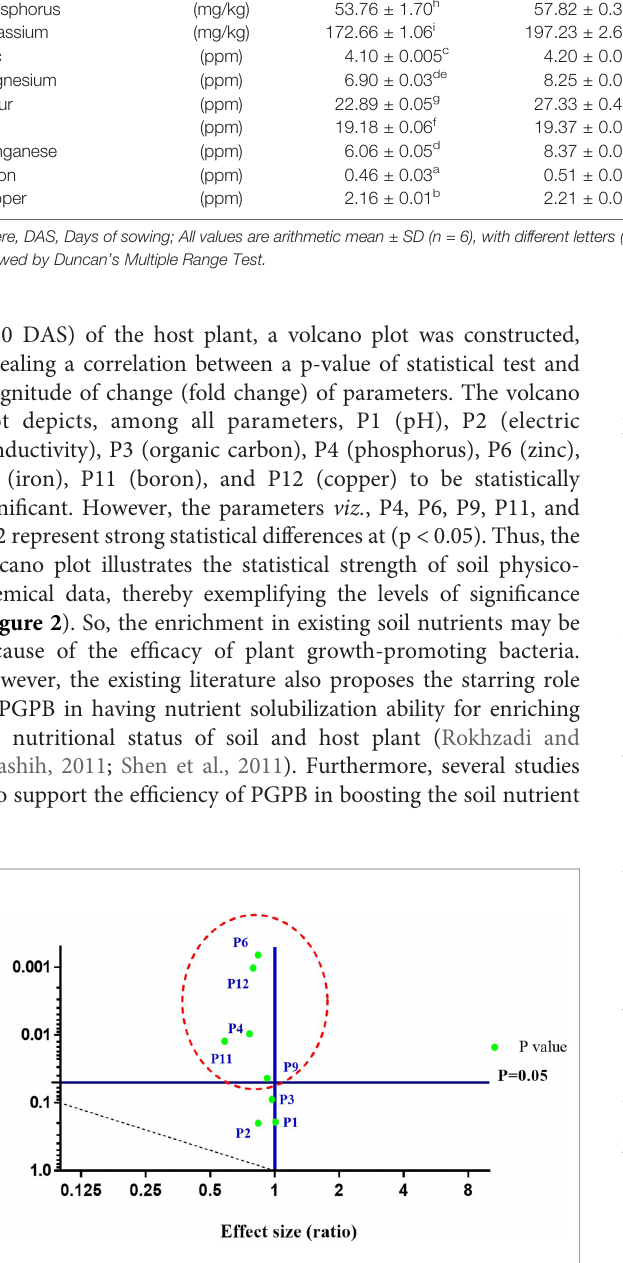
FIGURE 2 | A volcano plot representing effects of bacterial treatments on soil parameters before (0 DAS) and after harvesting (120 DAS) of C. annuum L. Where DAS: days after sowing; P1: pH; P2: Electric conductivity; P3: Organic carbon; P4: Phosphorus; P6: Zinc; P9: Iron; P11: Boron; P12: Copper. The parameters viz. , P4, P6, P9, P11, and P12 represent strong statistical differences (p < 0.05). All the values are arithmetic mean ± SD; n =